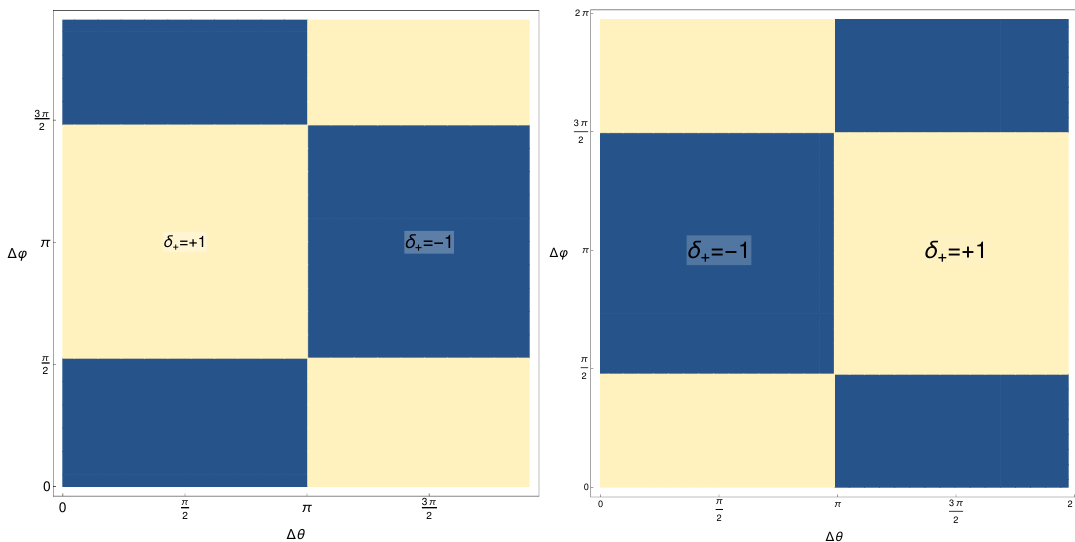
Figure 4: Different values of δ + for difference in the directions of boundary fields (cid:126) = ( sin θ ) and (cid:126) b = ( sin θ ) . b cos ϕ ,sin θ sin ϕ ,cos θ cos ϕ ,sin θ sin ϕ ,cos θ L L L L L L 1 1 1 1 1 1 − ϕ − θ We have defined ∆ ϕ = ϕ and ∆ θ = θ . The direction of boundary field L L 1 1 = ϕ = π at the first site is fixed by θ and we change the angles at end point of 1 1 200 the chain. On the right, we have L = 9 and left hand side corresponds to L = 10. Rest of the parameters are: J = − 1, γ = 1 / 2 and h =